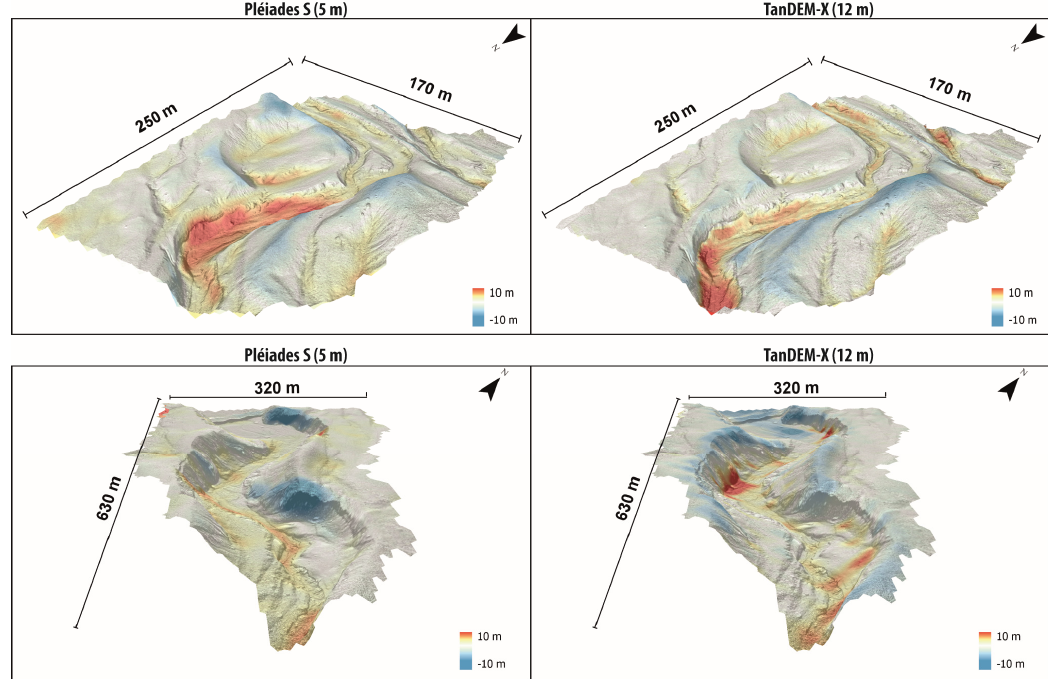
Figure 10. Spatial distribution of elevation differences of Pléiades S and TanDEM-X 12 m data compared to UAV reference data at two different sites. Pléiades satellite imagery data: © CNES (2016), Distribution Airbus DS. TanDEM-X World WorldDEM™ data: © DLR (2017). .